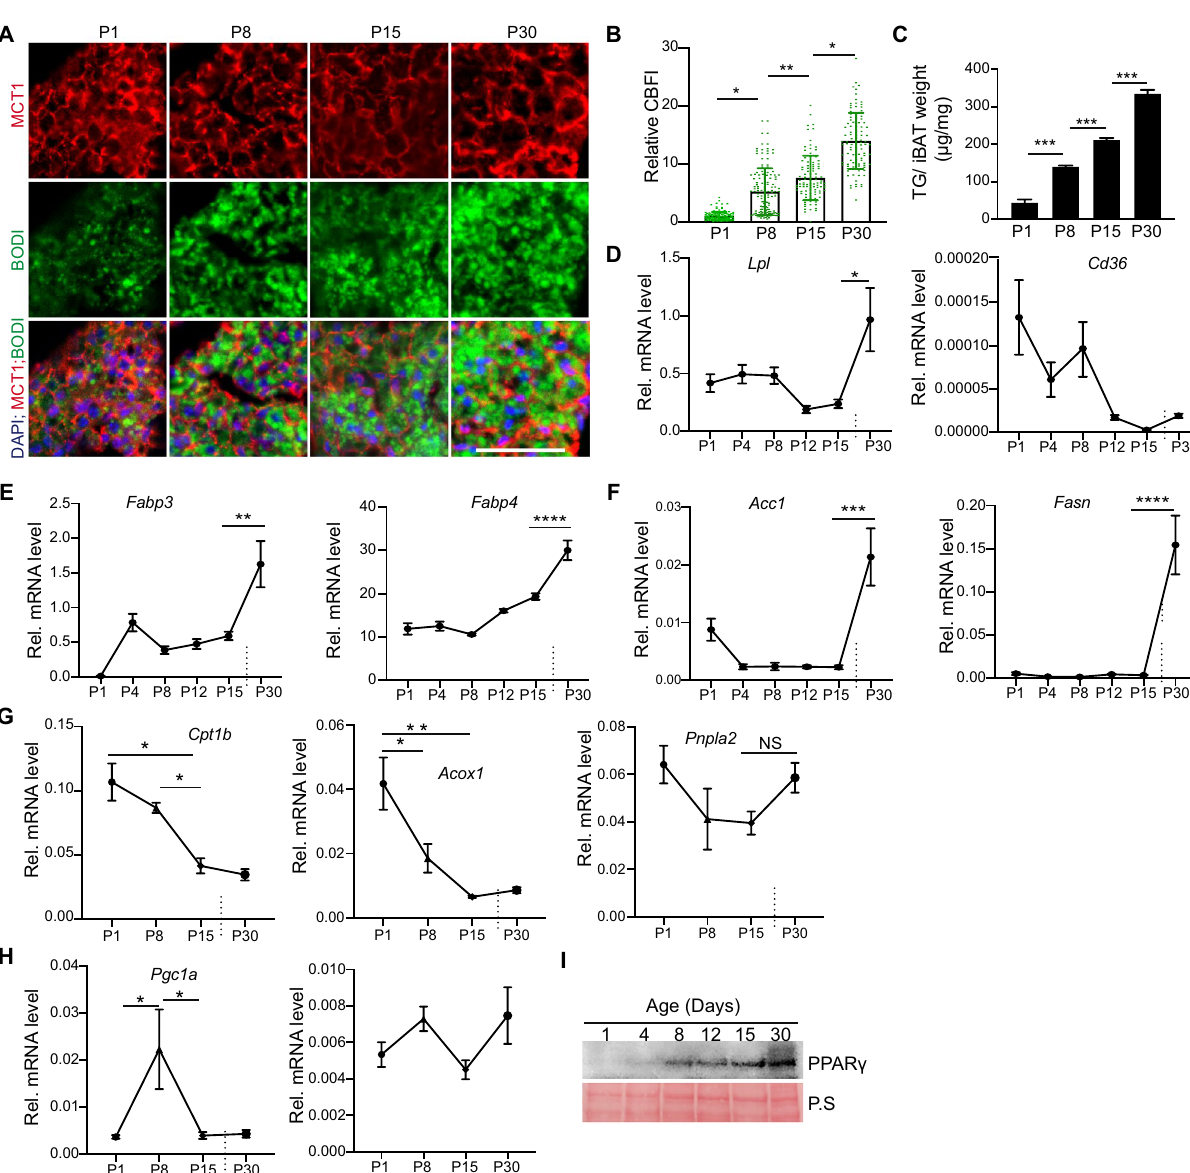
Figure 2. Lipogenesis is associated with BAs hypertrophic growth. ( A ) Immunofluorescence staining images of iBAT tissue at different ages. Lipid droplets were visualized with BODIPY 493/503 (BODI). Bar = 50 µm. ( B ) Quantification of cellular BODIPY fluorescence intensity (CBFI). In each group, 100–120 BAs from three independent animals were analyzed. The relative CBFI was calculated by normalizing the CBFI value of each cell against the average CBFI of P1 BAs. In the bar graph, each dot represents one single cell. Brown-Forsythe and Welch ANOVA tests with multiple comparisons test, * P < 0.05; ** P < 0.01 . ( C ) Measurement of triglycerides (TG) contents of iBAT. ( D–H ), qRT-PCR measurement of gene expression at different ages. Total RNA from iBAT was used for qRT-PCR. Gene expression level was normalized to 36B4. (C–H) One-way ANOVA with